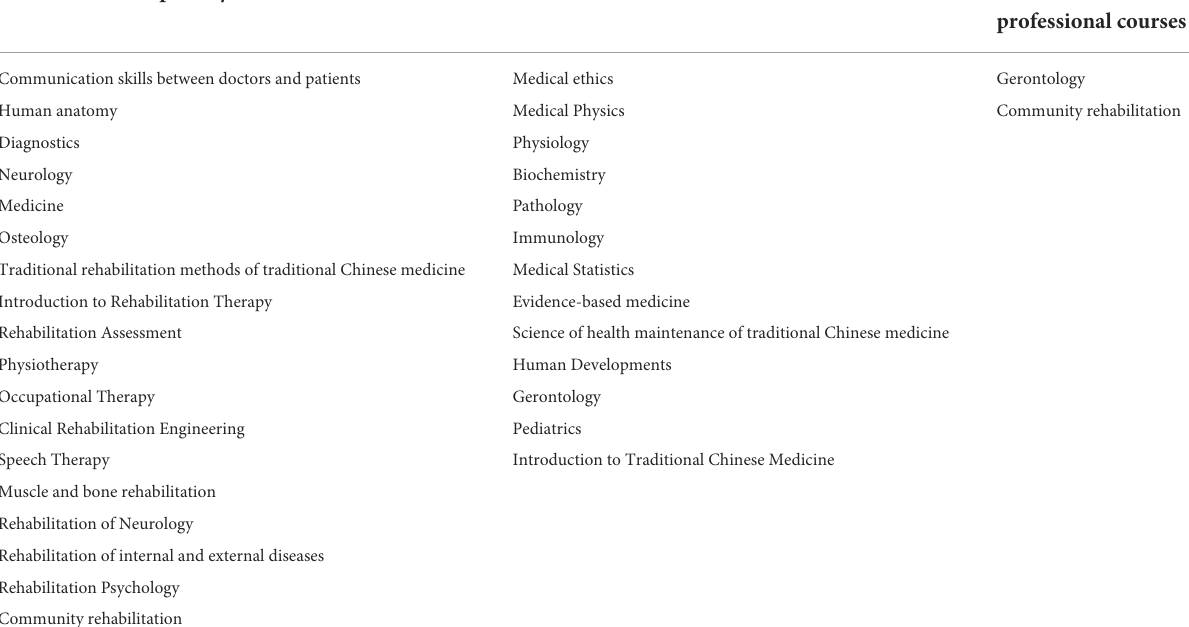
TABLE 4 Curriculum design based on Weifang Medical